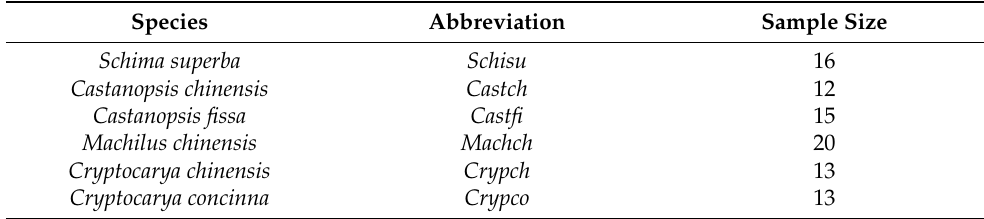
Table 1. Details of the six dominant tree species in the